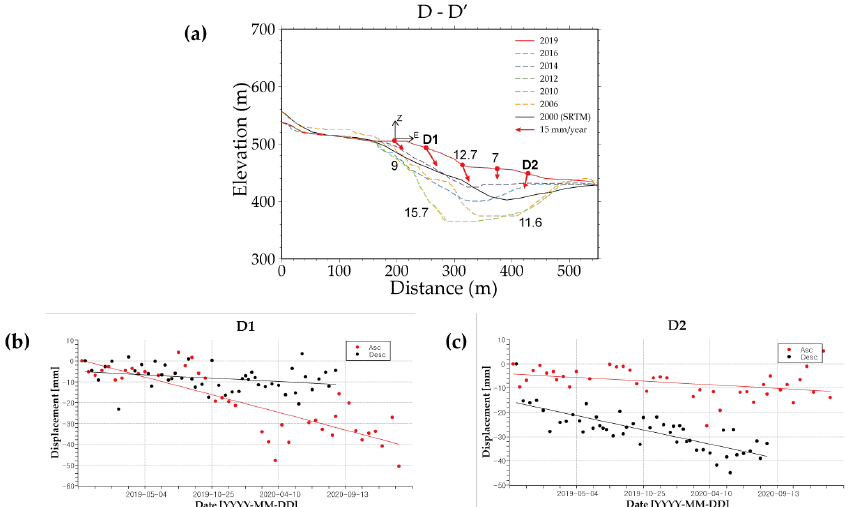
Figure 11. Elevation change and displacement along the D-D’ on the slope of the mined-out area. ( a ) Cross section of D-D ’ , and change along the slope and time-series plots of displacement in ( b ) D1 and ( c ) D2 from the ascending and descending orbits with arbitrary offsets. The DEM was obtained from the National Geographic Information Service of Korea, except for the SRTM in 2000.